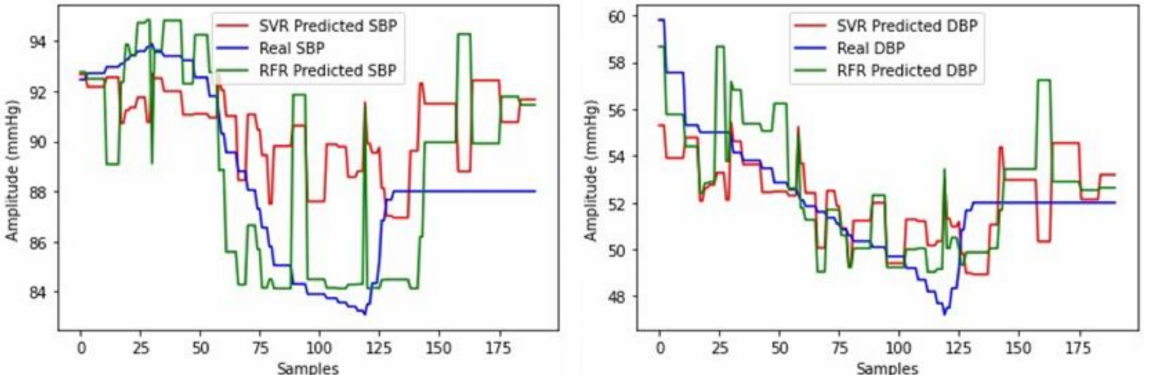
Figure 19. Comparison between real and predicted SBP and DBP values obtained with the ran- dom forest regressor ( MAE SBP = 2.16 ± 3.95 mmHg, MAE DBP = 1.52 ± 2.62 mmHg) and SVR ( MAE SBP = 2.84 ± 1.62 mmHg, MAE DBP = 1.55 ± 1.70 mmHg). The values belong to subject